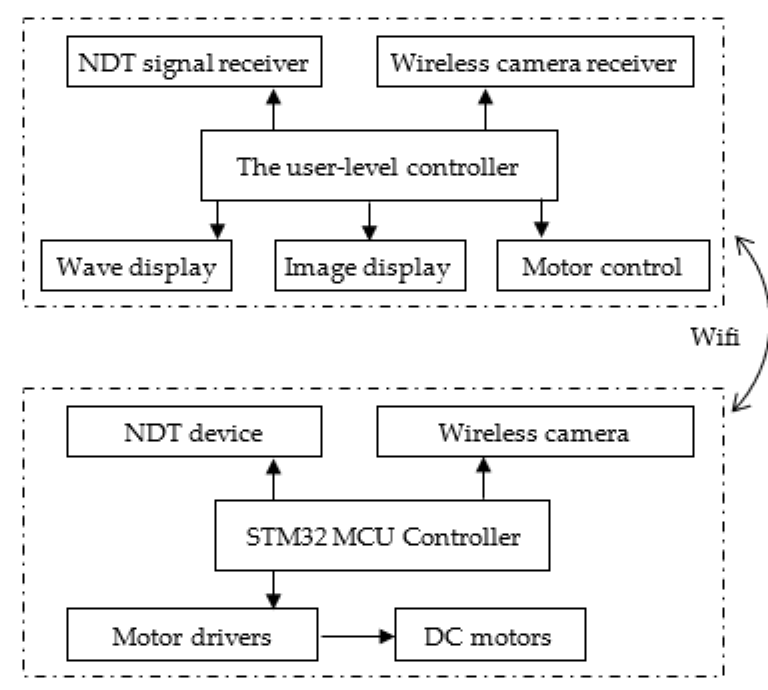
Figure 9. The control architecture of WRR-II.